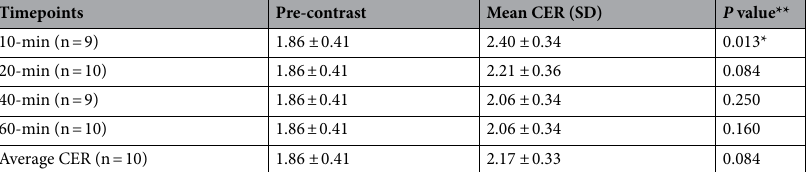
Table 2. Gadoxetate disodium enhancement over time in localized prostate cancer subgroup. Localized prostate cancer takes up Eovist at 10-min timepoint but does not retain it over time. * Significant p value ** Statistical test used—Wilcoxon